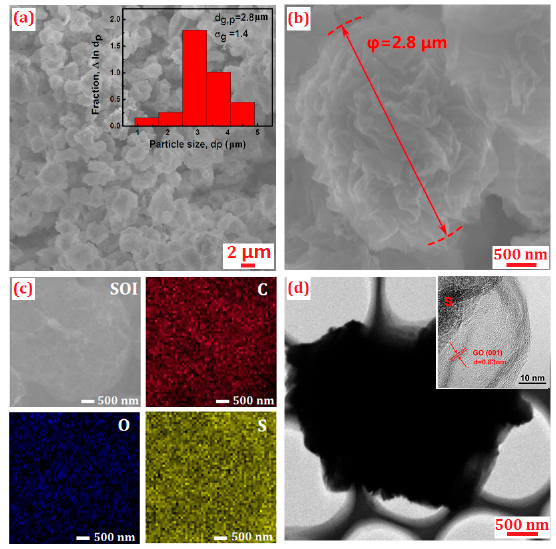
Figure 3. ( a , b ) SEM images of S/GO composites and the particle-size distribution of S/GO composites; ( c ) EDS mapping showing the distribution of carbon (C), oxide (O), and sulfur (S), in the S/GO composites; ( d ) TEM images of S/GO composites at different magnifications.